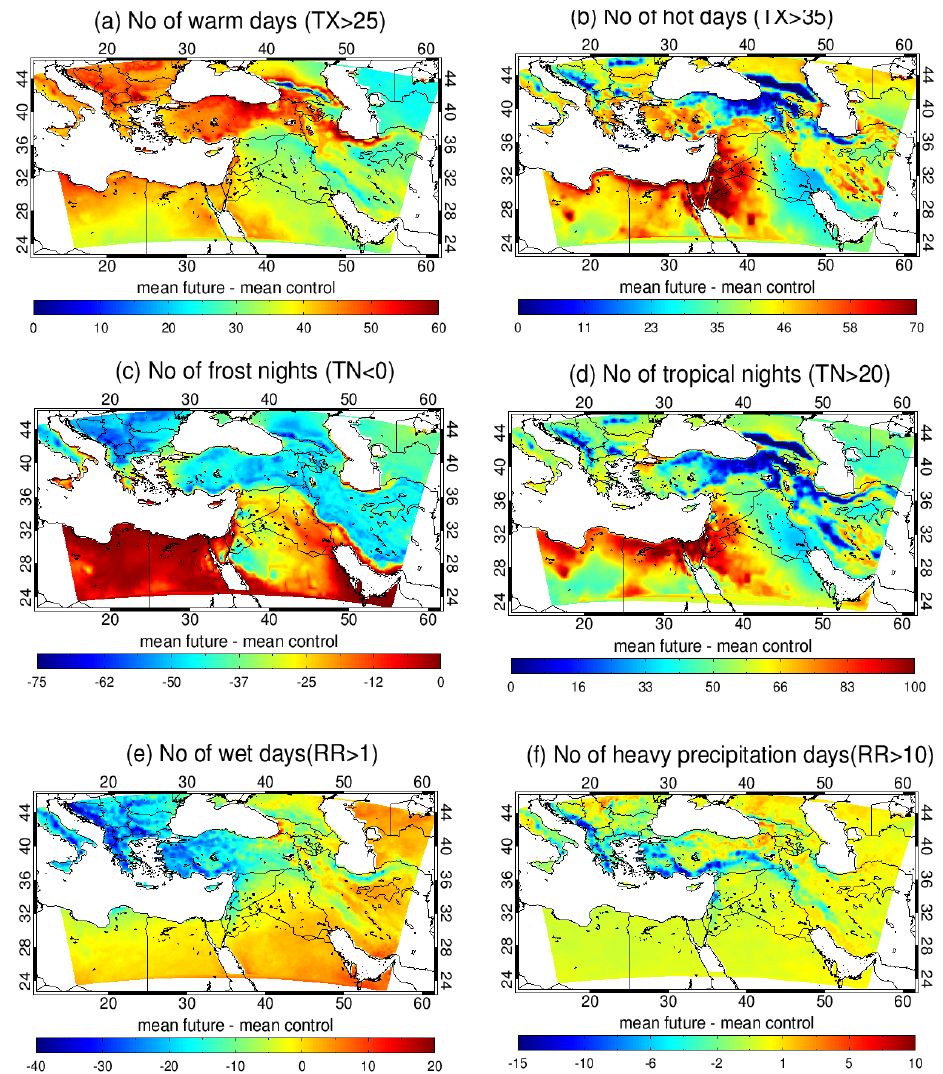
Figure 7. Spatial patterns of the mean changes in the number of warm days (a) , hot days (b) , frost nights (c) , tropical nights (d) , wet days (e) and days with heavy precipitation (f) , for the future period 2070–2099 relative to the control period 1961–1990.